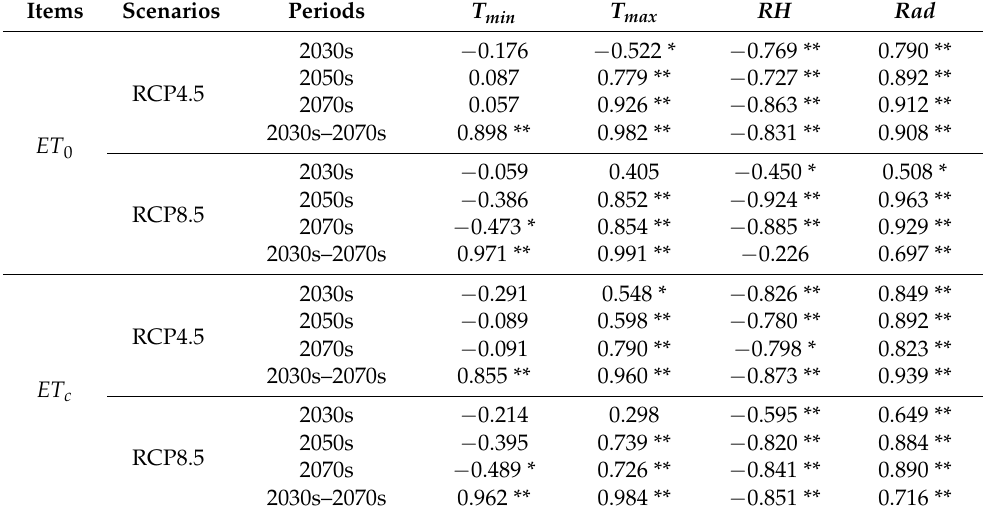
Table 2. Correlation analysis among ET 0 , ET c , P e , I r , and meteorological factors during the soybean growth period.